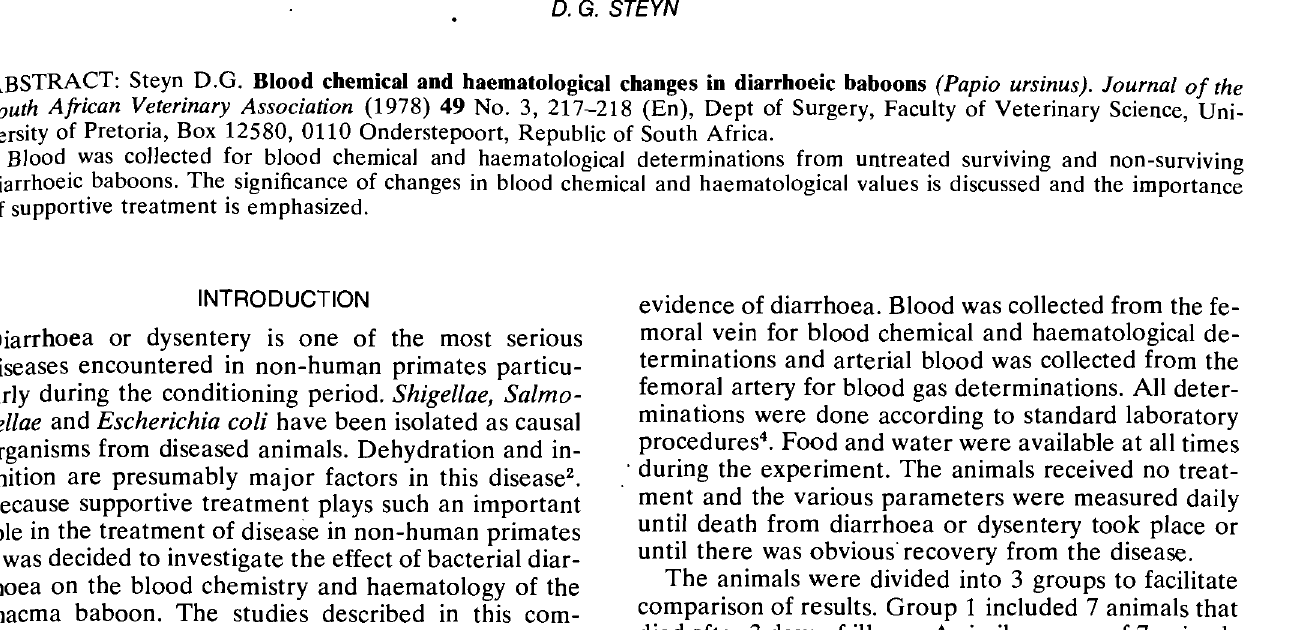
Table 1: BLOOD CHEMICAL DETERMINATIONS IN DIARRHOEIC